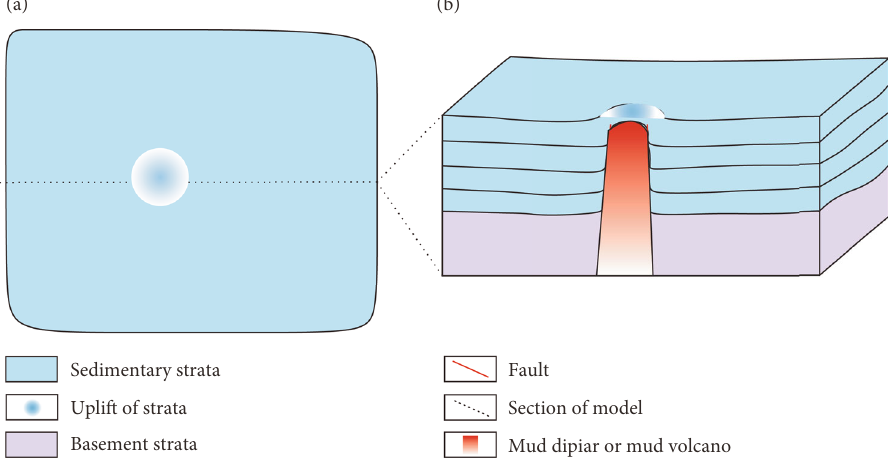
Figure 11: Development mechanism model of mud diapirs/mud volcanoes under simple overpressure background. (a) The top view of the strata after the development of mud diapirs/mud volcanoes under overpressure background. It can be observed that a stratigraphic uplift is on the position where mud diapir or mud volcano develops. (b) Three-dimensional map of the development mechanism of mud diapirs/mud volcanoes under overpressure background. The strata around mud diapirs/mud volcanoes are almost vertical faulted, the strata at the development position of mud diapirs/mud volcanoes are obviously pulled up, and the top strata are